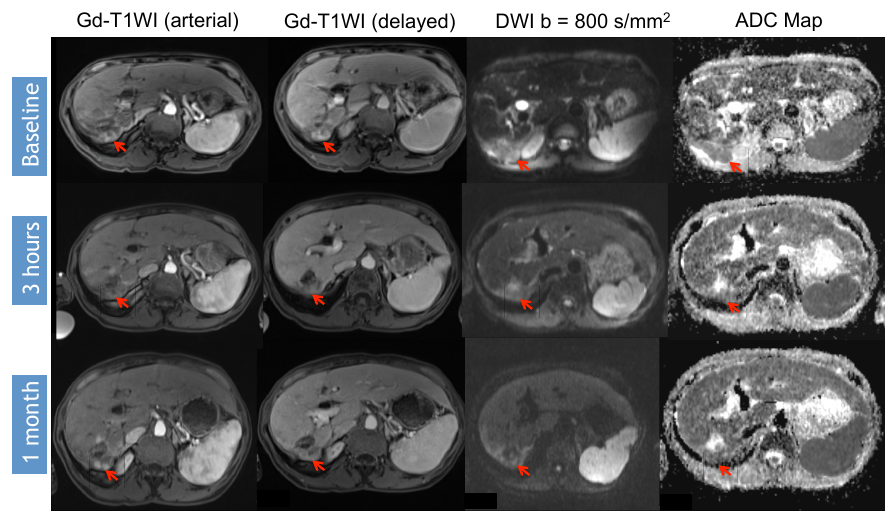
Figure 3. DWI Response Assessment after DEB-TACE treatment. 55-year-old woman presented with a segment VII HCC (arrow) previously treated with DEB-TACE without macrovascular invasion or extrahepatic disease. Note that there is initial absence of enhancement at 3 h, but the area continues to demonstrate restricted diffusion (ADC 0.904 × 10 −3 mm 2 /s). At one month, the same area now demonstrates enhancement with increased restricted diffusion, findings consistent with progression of disease (PD) (baseline ADC 0.904 × 10 −3 mm 2 /s, post-3 h ADC 1.02 × 10 −3 mm 2 /s, post-one month ADC 0.830 × 10 −3 mm 2